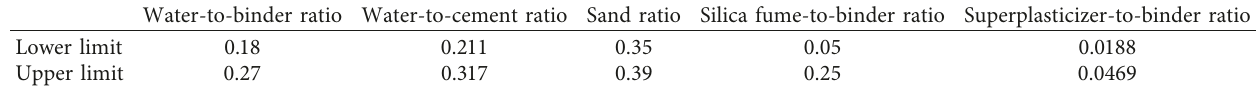
Table 3: Constraints of the ratios of concrete